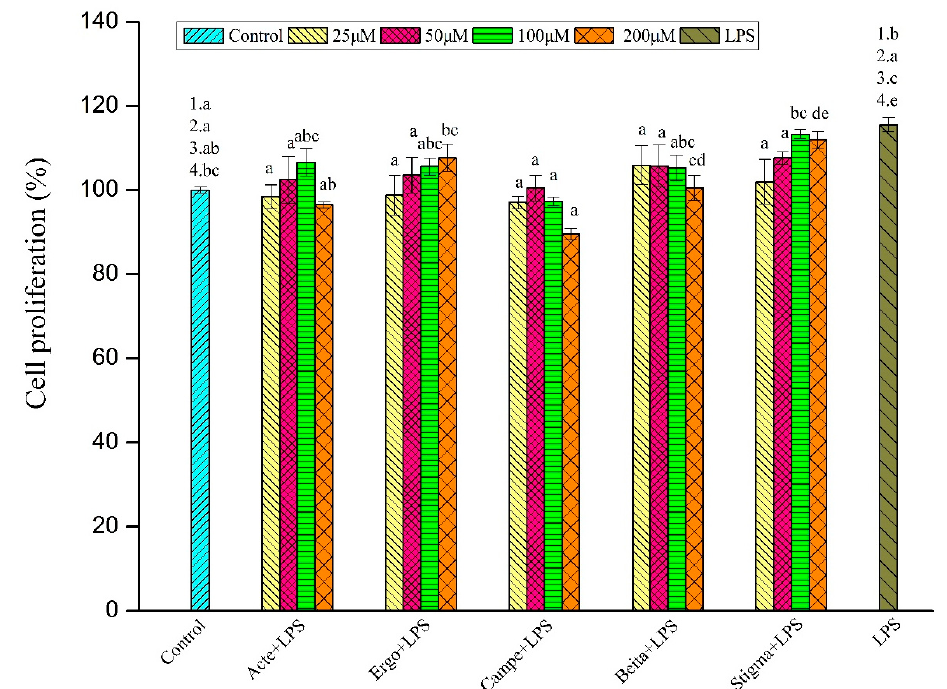
Figure 2. E ff ects of phytosterols on the proliferation of lipopolysaccharide (LPS)-stimulated RAW264.7 macrophages ( n = 6). Acte (ergosterol acetate); Ergo (ergosterol); Campe (campesterol); Beita ( β -sitosterol); Stigma (stigmasterol). The data are expressed as means ± standard error of the mean (SEM); different superscript letters for columns at the same concentration denote a significant difference ( p < 0.05); the numbers describe that the control/model group was compared with the experimental group at concentrations of 25 (1), 50 (2), 100 (3), and 200 (4) μ M.